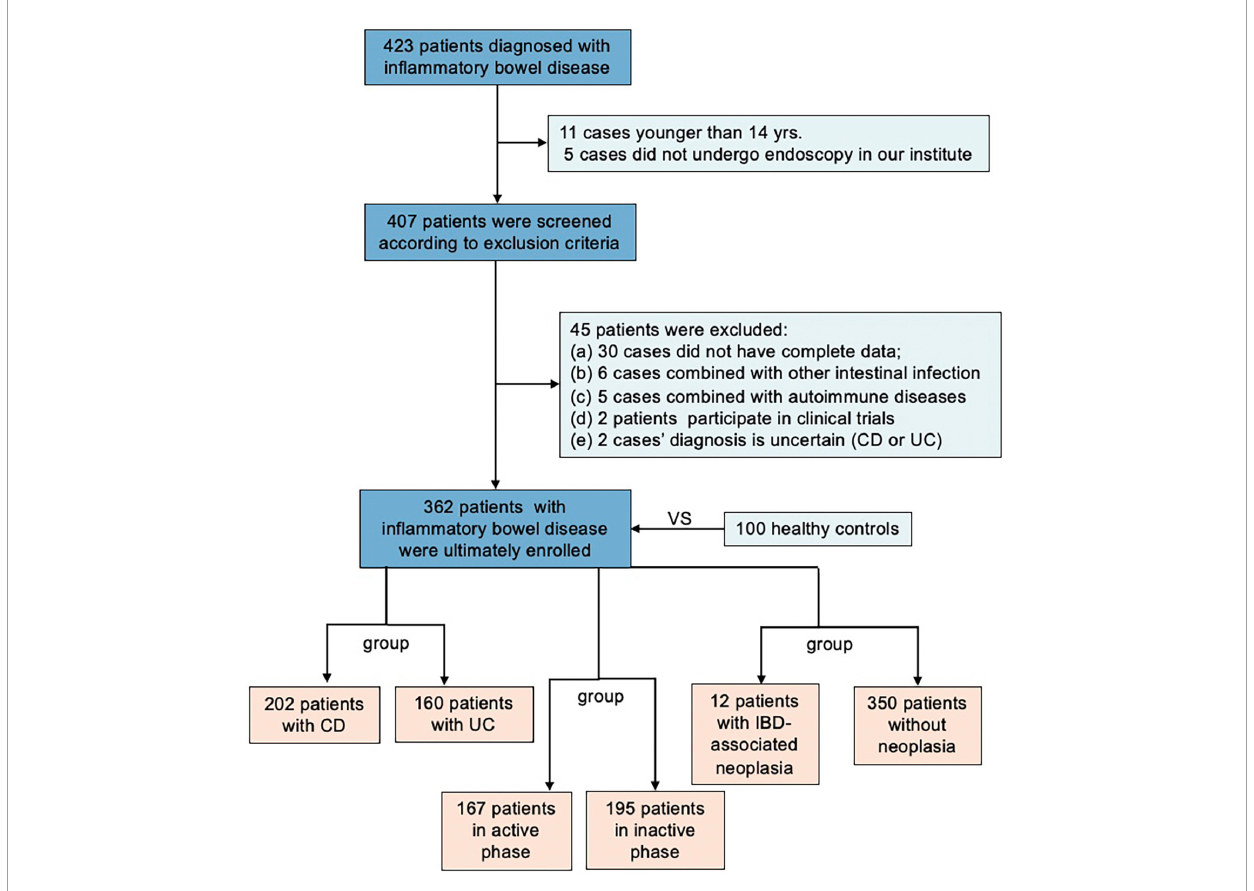
FIGURE1 The flowchart of screening eligible patients and grouping subjects in the present